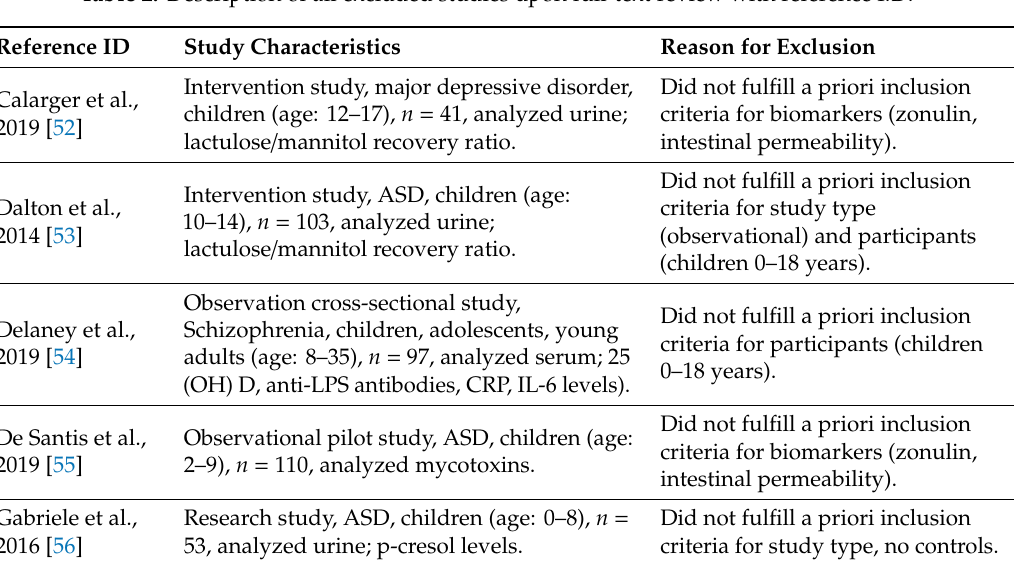
Figure 1. PRISMA flow diagram illustrating the results of the search, the process of screening, and the selection of the records for inclusion in the systematic review and meta-analysis. Table 2. Description of all excluded studies upon full-text review with reference